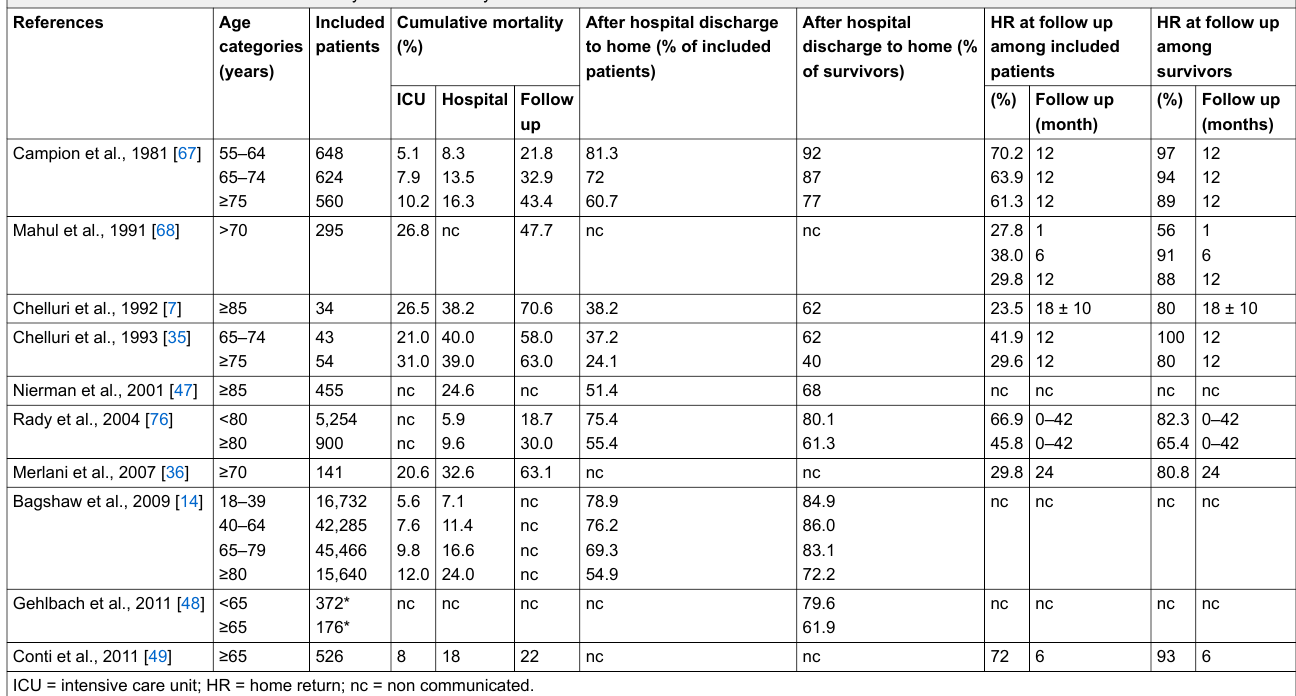
Table 2: Home return and cumulative mortality after an ICU stay.